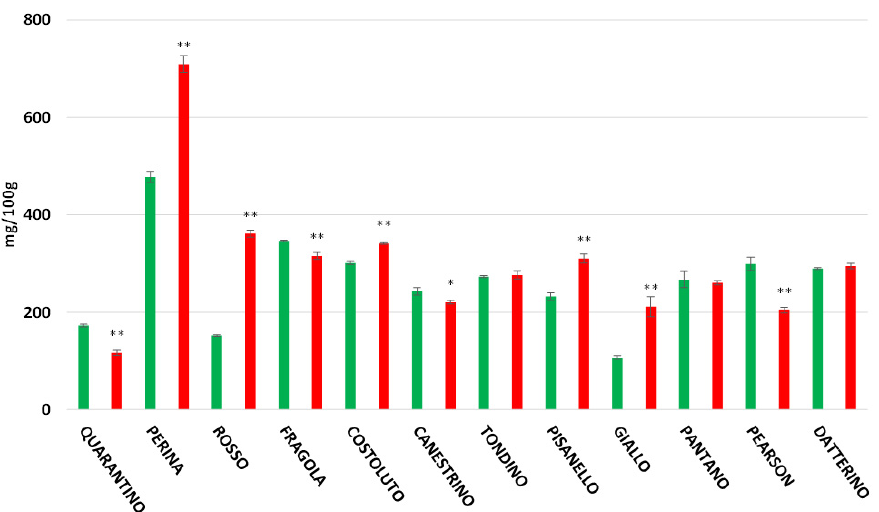
Figure 5. Total polyphenol content (expressed as mg/100 g of FW) in tomato peel of 9 Italian cultivars and three commercial cultivars. Controls (CTRL) in green and drought-stressed group (DS) in red. The bars indicate the standard deviation. A significant difference is shown between CTRL and DS of each cultivar by * for a p ≤ 0.05 and ** for p ≤ 0.01.